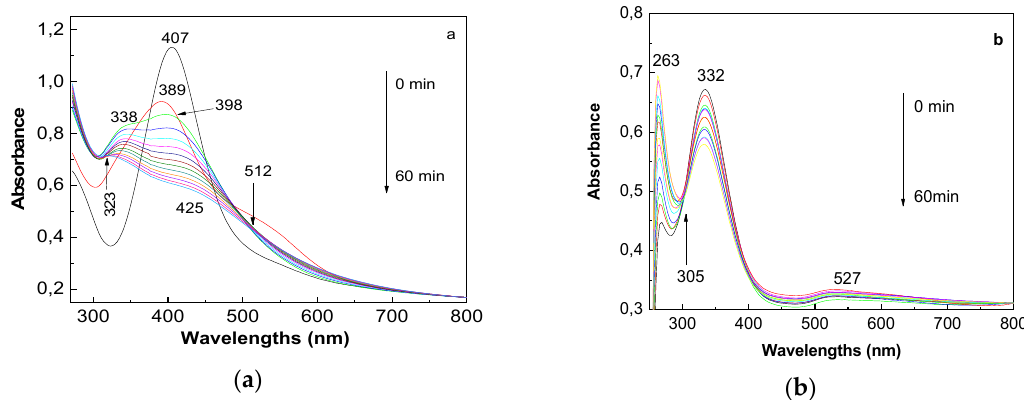
Figure 7. The influence of the UV light on the ALA solution resulting from the dissolution of 1 mg of ALA in the presence of ( a ) 0.5 mg RGO sheets in 1 mL of DMF and 1 mL of Ag nanoparticles with a size of 5 nm and ( b ) 0.5 mg RGO sheets in 1.5 mL of DMF and 0.5 mL of Ag nanoparticles with a size of 5 nm. The black curve in Figure a shows the UV-VIS spectrum of 0.5 mg RGO sheets in 1 mL of DMF and 1 mL of Ag nanoparticles with a size of 5 nm in the absence of ALA. The two samples' UV- VIS spectra were recorded at intervals of 5 min of exposure to UV light, for 60 min.